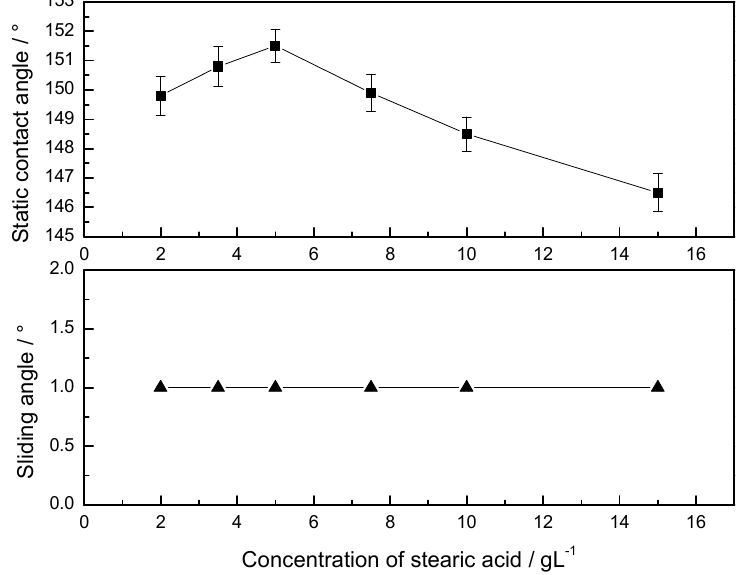
Figure 1. Variations of SCAs, SAs with the concentration of stearic acid.